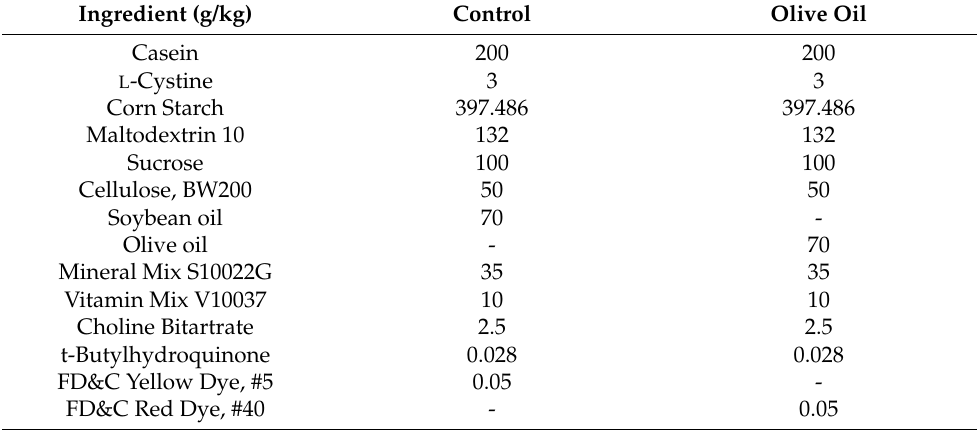
Table 1. The composition of experimental